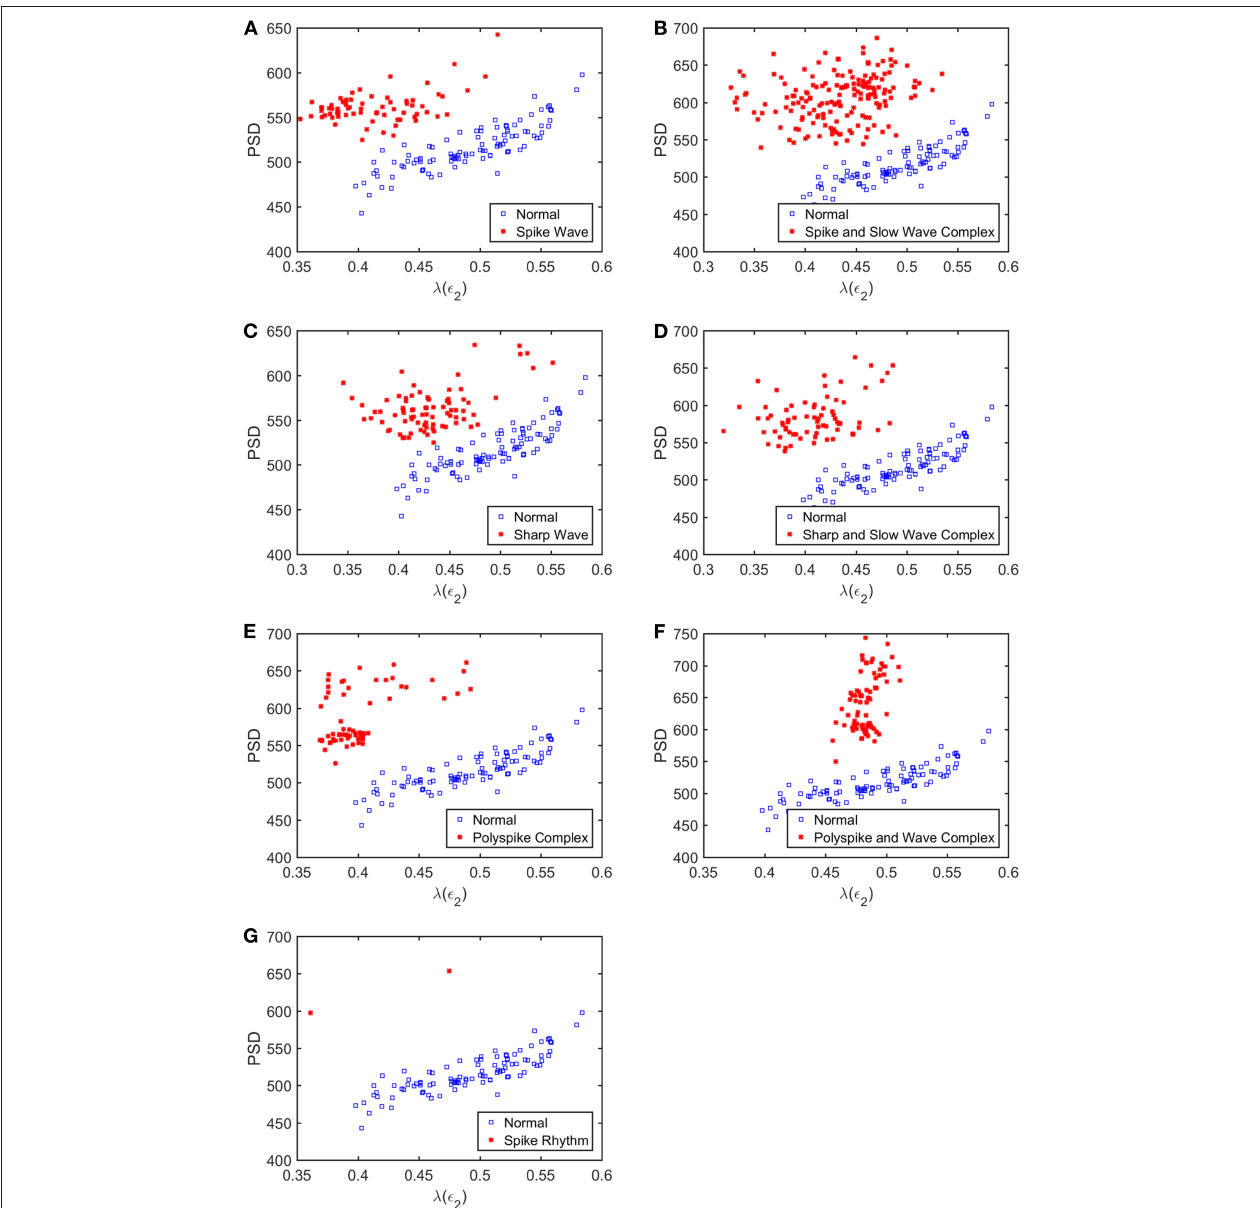
FIGURE 6 | Scatter plots with PSD and λ (e2), where (A–G) , illustrates the different between the seven types of epileptiform discharges (spike wave, spike and slow wave complex, sharp wave, sharp and slow wave complex, polyspike complex, polyspike and slow wave complex, spike rhythm discharges) and normal EEG. These plots highly suggest the classification accuracy will be very